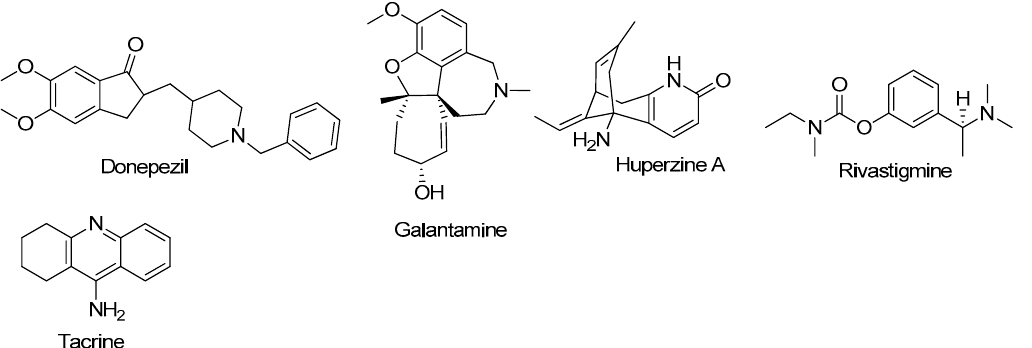
Figure 1. The acetyl cholinesterase enzyme (AChE) inhibitors currently employed in the treatment of Alzheimer’s disease (AD).